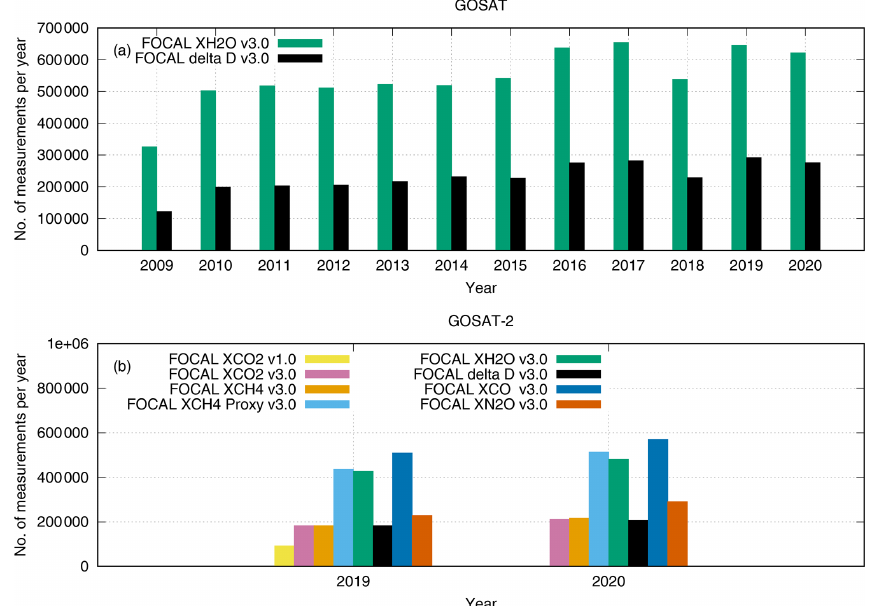
Figure 2. Number of FOCAL GOSAT and GOSAT-2 data as a function of time. (a) GOSAT FOCAL XH 2 O and δ D; (b) GOSAT-2 FOCAL